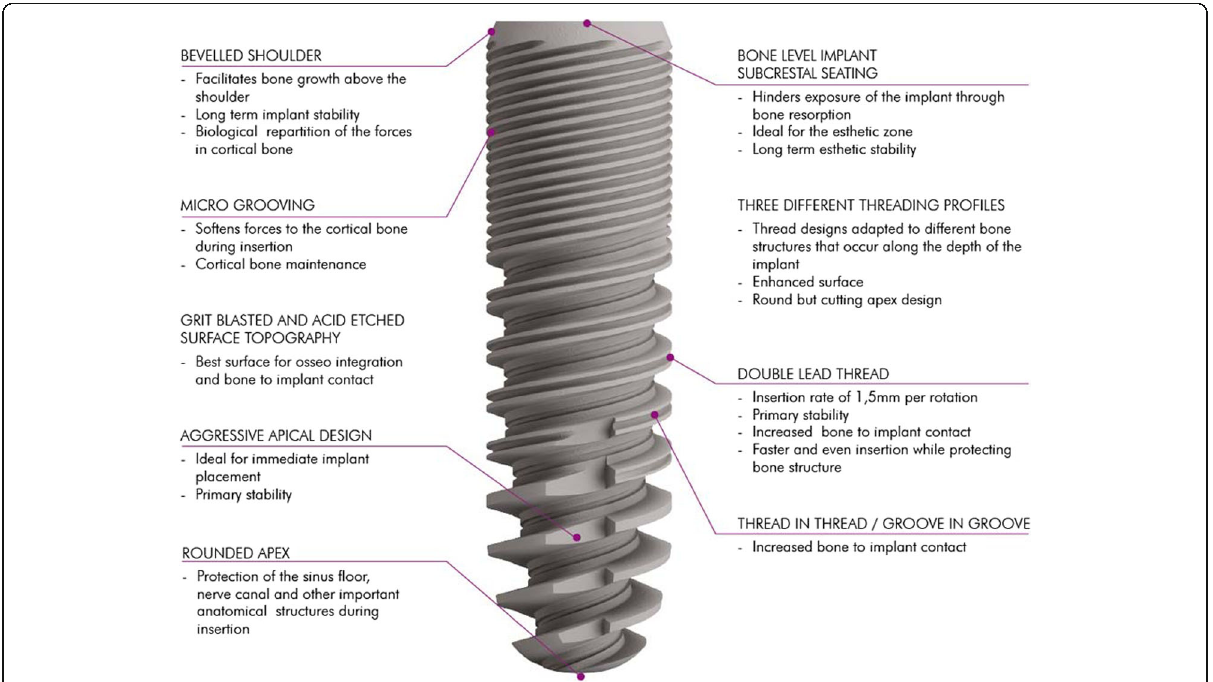
Fig. 1 Schematic representation of the technical characteristics of the investigated C-Tech Esthetic Line implant system (provided by the